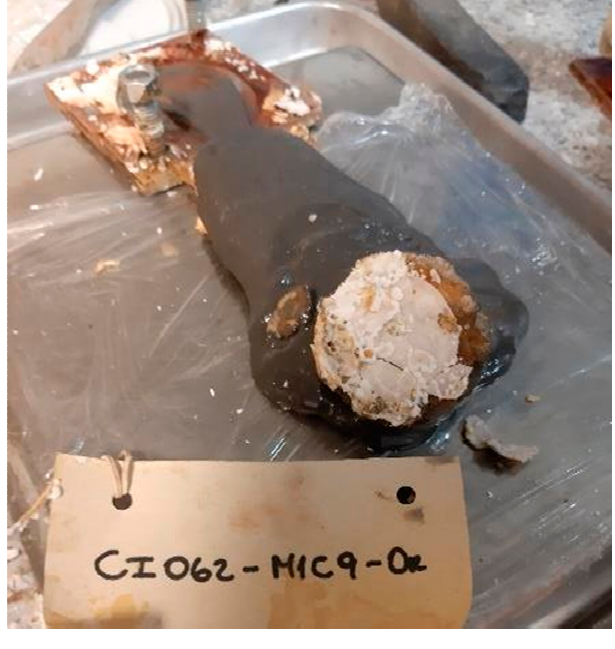
Figure 7. Carbonation observed in the geopolymer created by Method 1, cured for 7 days at 60 °C.